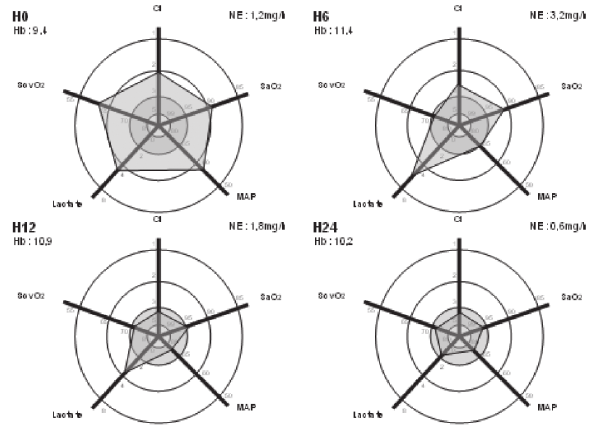
Figure 2 - Evolution of the target area between H0 and H24 for a patient in septic shock due to pneumonia: improvement of target parameters and reduction in the norepinephrine administration starting from